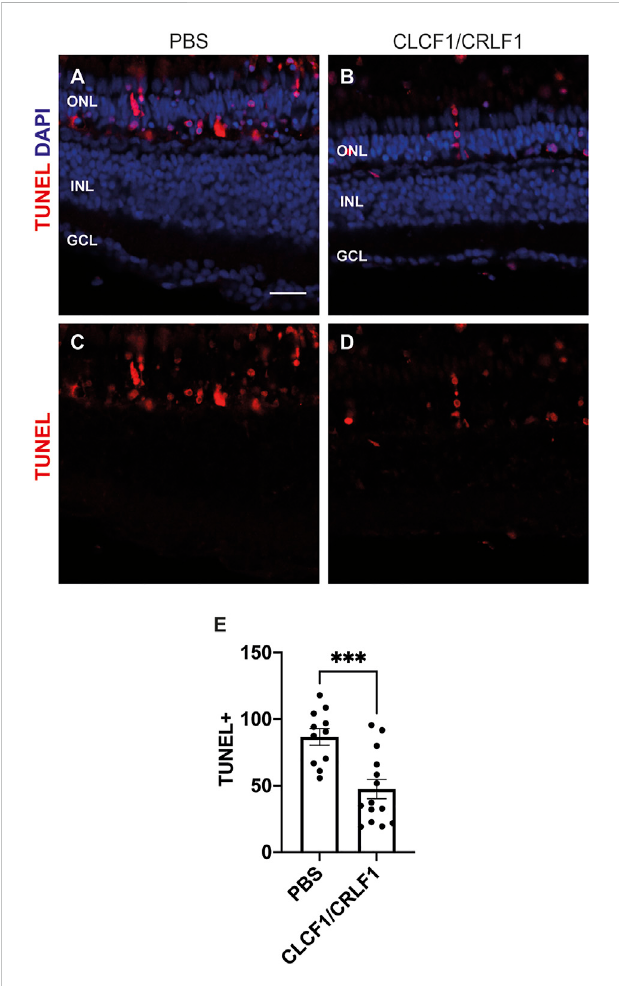
FIGURE 4 Intravitreal injection of CLCF1/CRLF1 protects against photoreceptor cell death during light treatment. (A – D) Single z-plane confocal images from dark-adapted albino zebra fi sh that were light- treatedfor24 hwhilebeingintravitreallyinjectedwitheitherPBS (A, C) or CLCF1/CRLF1 (B, D) . TUNEL assay was performed to assess cell death, and nuclei were counterstained with DAPI. (E) Quanti fi cation showing signi fi cant decrease in the number of TUNEL-positive nuclei within the ONL of CLCF1/CRLF1-treated retinas. Student ’ s t -test, p = 0.0005, n ≥ 11. Mean ± SEM, *** p < 0.001. ONL, outer nuclear layer, INL, inner nuclear layer, GCL, ganglion cell layer. Scale bar represents 20